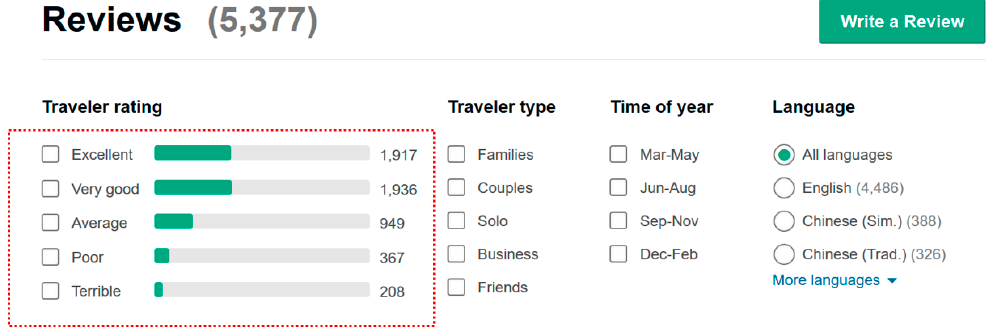
Table 1. Evaluation values for each hotel under criteria c 1 and c 2 Table 1 . Evaluation values for each hotel under criteria Table 1 . Evaluation values for each hotel under criteria